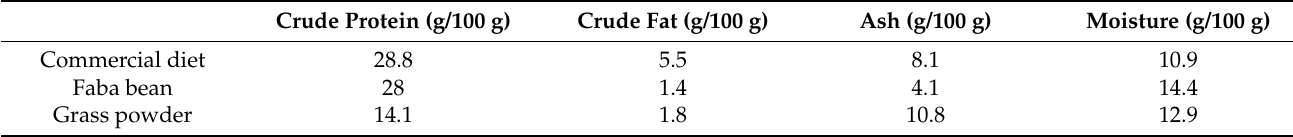
Table 1. Nutritional composition of different